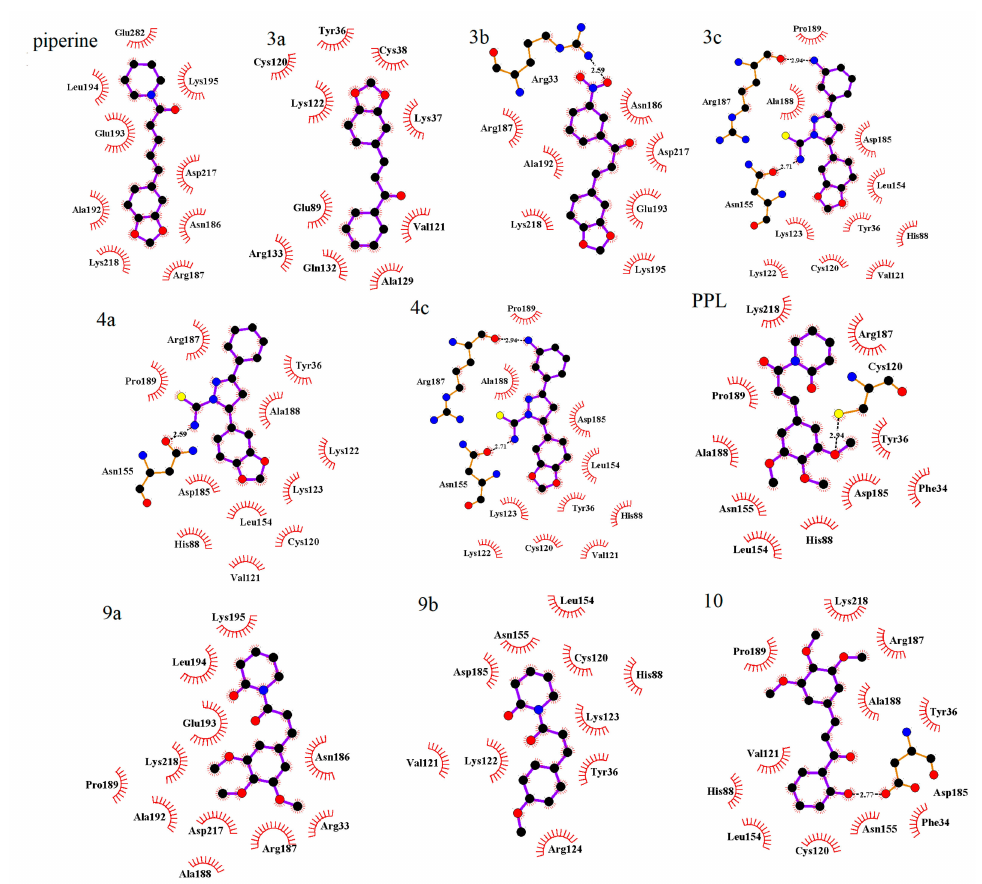
Figure 5. NF- κ B binding microenvironments details for piperine and PPL analogues visualized with